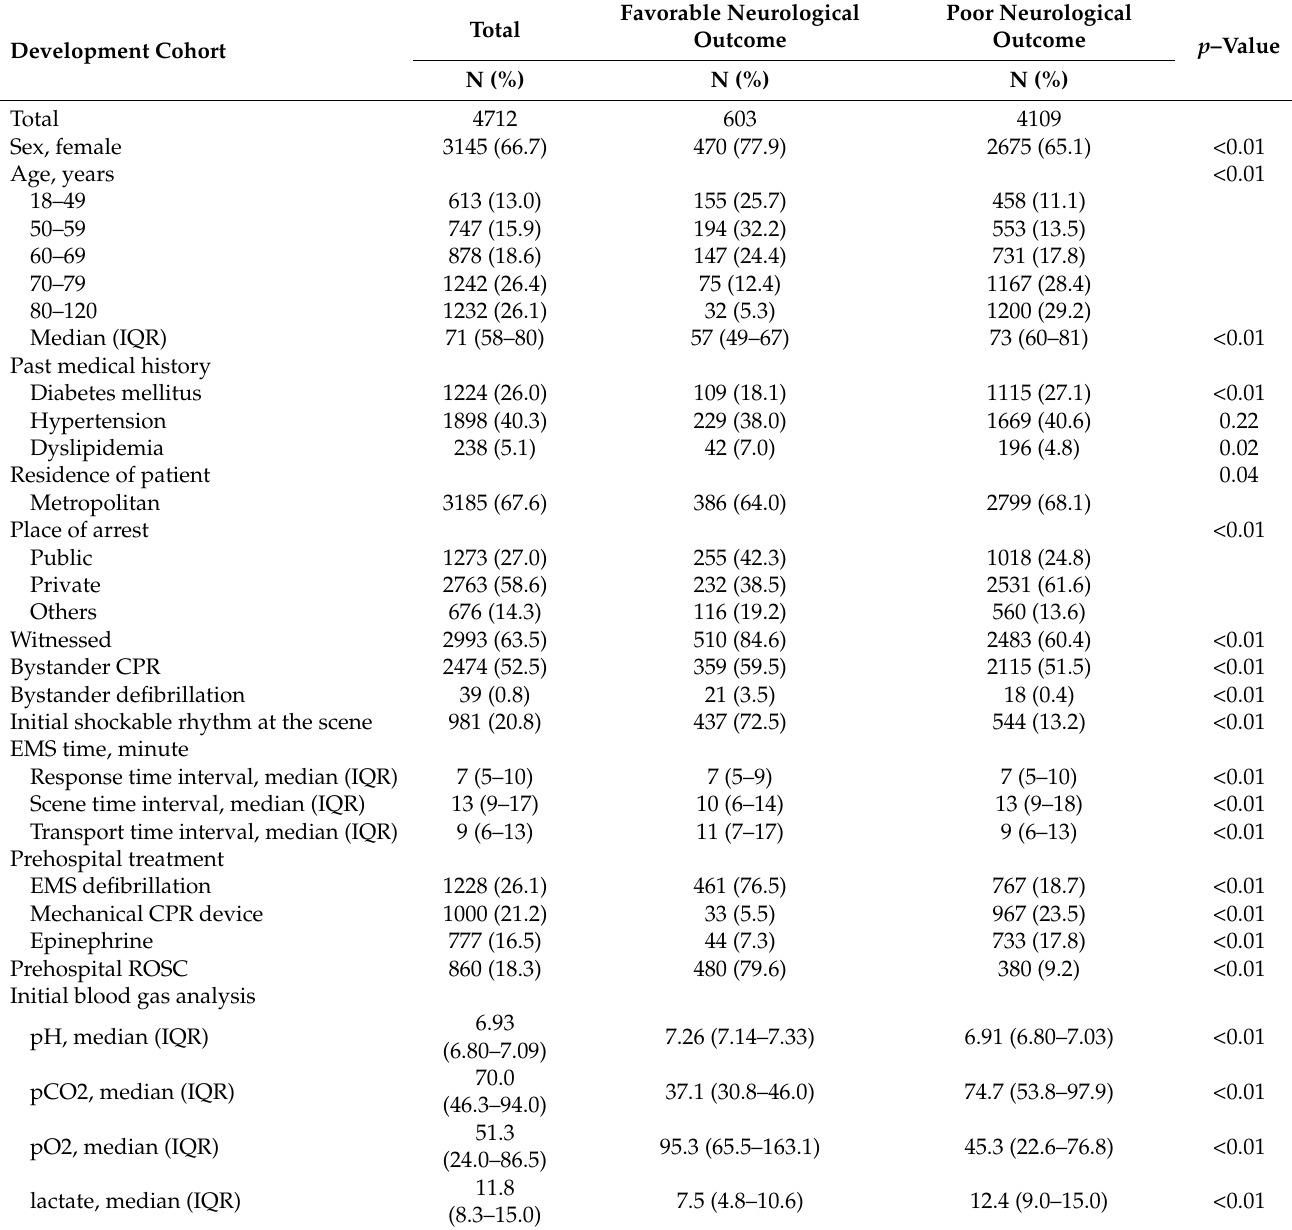
Table 1. Characteristics of the development cohort